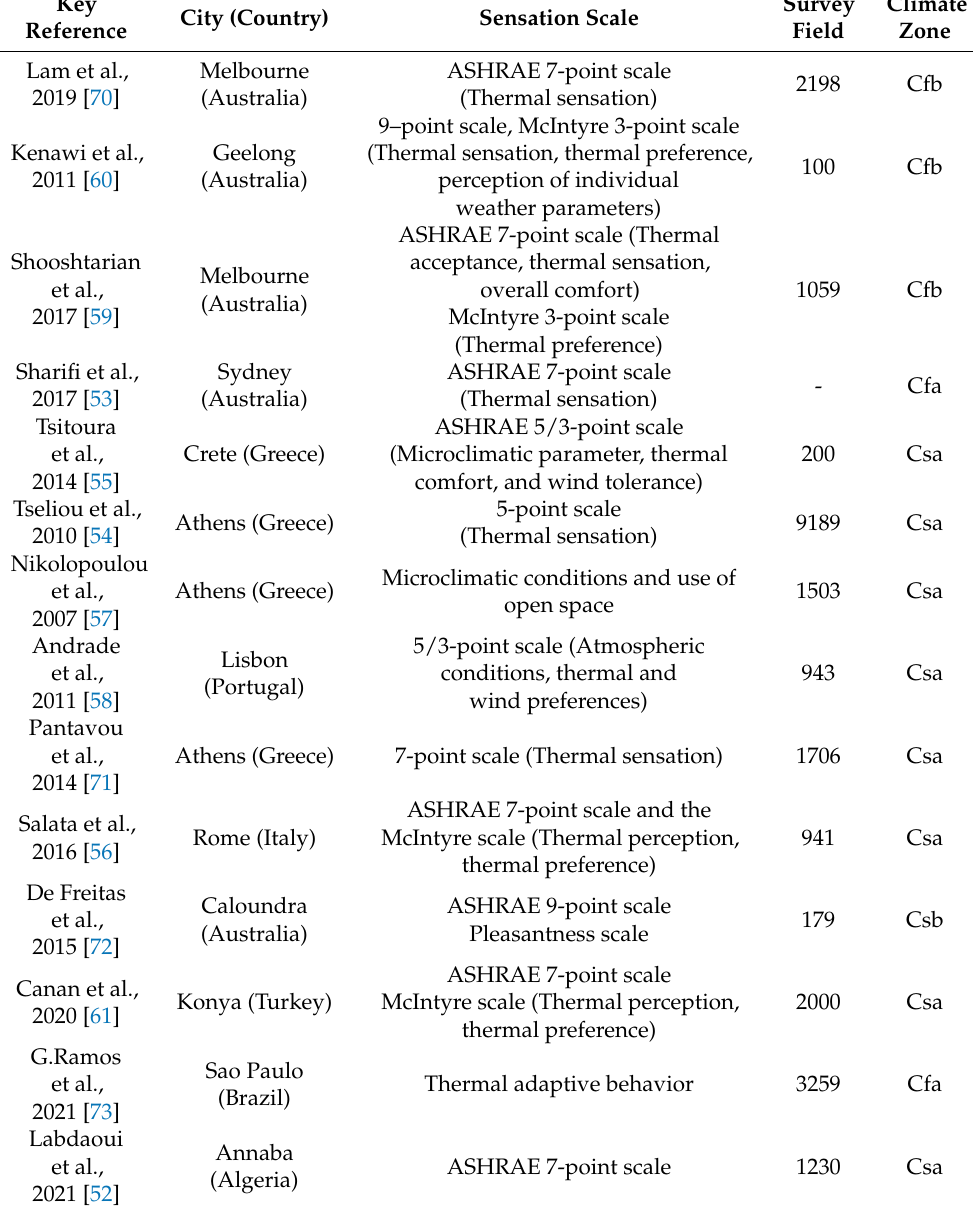
Table 3. List of studies that engaged subjective thermal perception with a